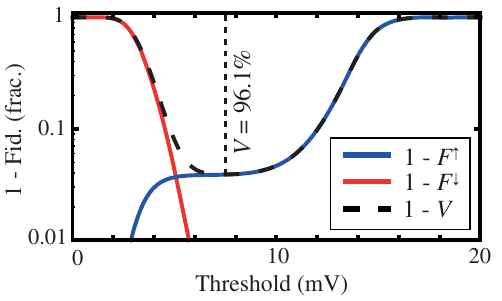
FIG. 8. Electrical readout fidelity. The complement of the electrical fidelities F ↑ (blue) and F ↓ (red) are shown as a STC STC function of the threshold used to distinguish between the two spin states. Reduction in fidelity is either caused by electrical noise or missing very fast tunnel events due to filtering or the limitation of the resonating circuit response time. The optimal threshold in ¼ F ↑ þ F ↓ − 1 is found to be terms of the visibility V STC STC STC 7.4 mV from R 0 resulting in V ¼ 96 . 1% falls below the noise floor of R 0 , but by this point F ↑ has already dropped sharply from missing short tunnel events that are filtered out by the resonator ’ s 51 ns response time ¼ 96 . 1% , and fail to reach R 1 . At the optimal threshold V E which when combined with V gives an overall meas- STC ¼ 97% . urement fidelity F M